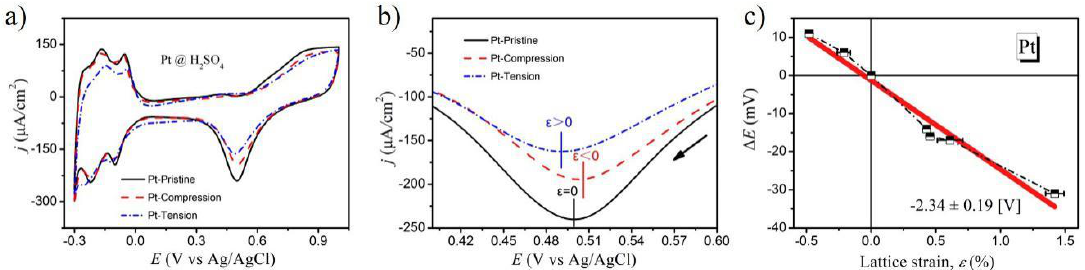
Figure 4. ( a ) CV curves of the Pt surface under di ff erent strain states at 10 mV · s − 1 in 10 mM H 2 SO 4 ; Figure 4. a ) CV curves of the Pt surface under different strain states at 10 mV·s −1 in 10 mM H 2 SO 4 . b ) ( b ) Oxygen desorption peak of the Pt electrodes; ( c ) The desorption potential variation is plotted as a Oxygen desorption peak of the Pt electrodes. c ) The desorption potential variation is plotted as a function of the lattice function of the lattice strain.